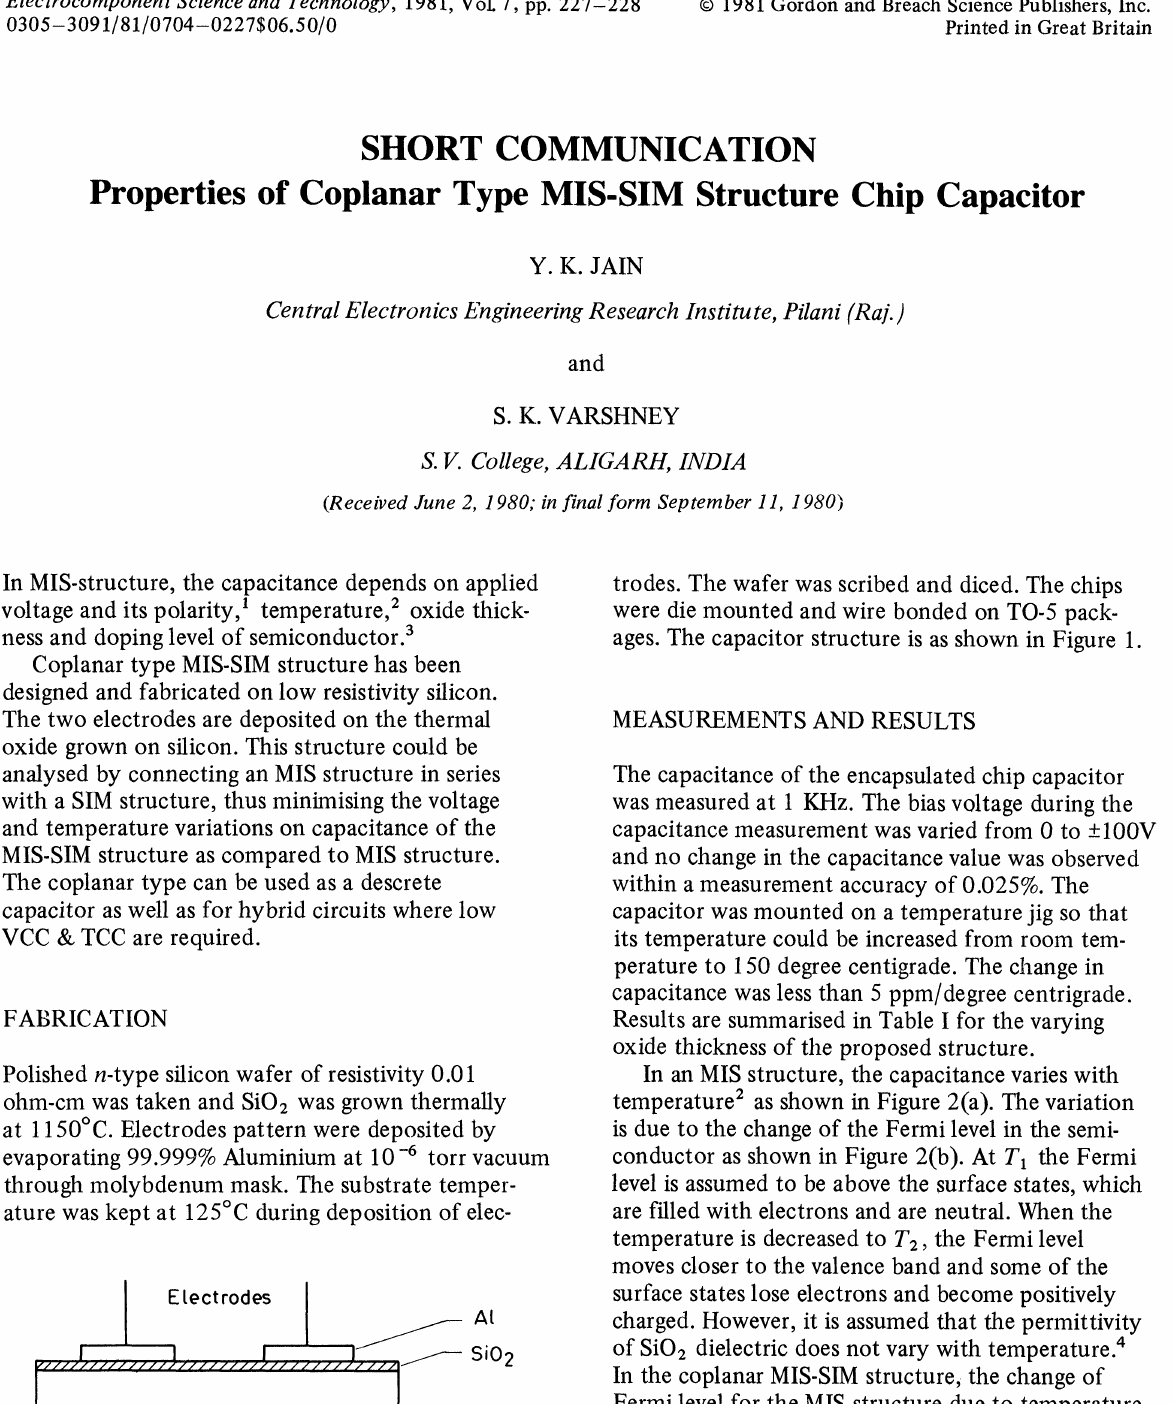
FIGURE Structure of coplanar type MIS-SIM